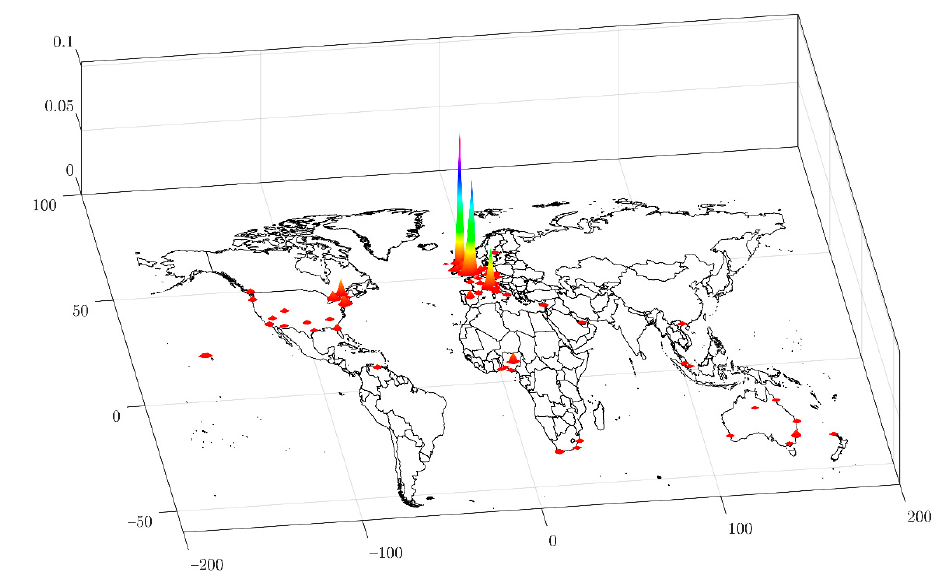
Figure 1. Geolocation of tweets published on COVID-19 and sport. The three − dimensional color bars show the density of tweets (kernel density). Larger size indicates a higher density of tweets in the area. Only those tweets that were geo − tagged are shown ( n = 4932).